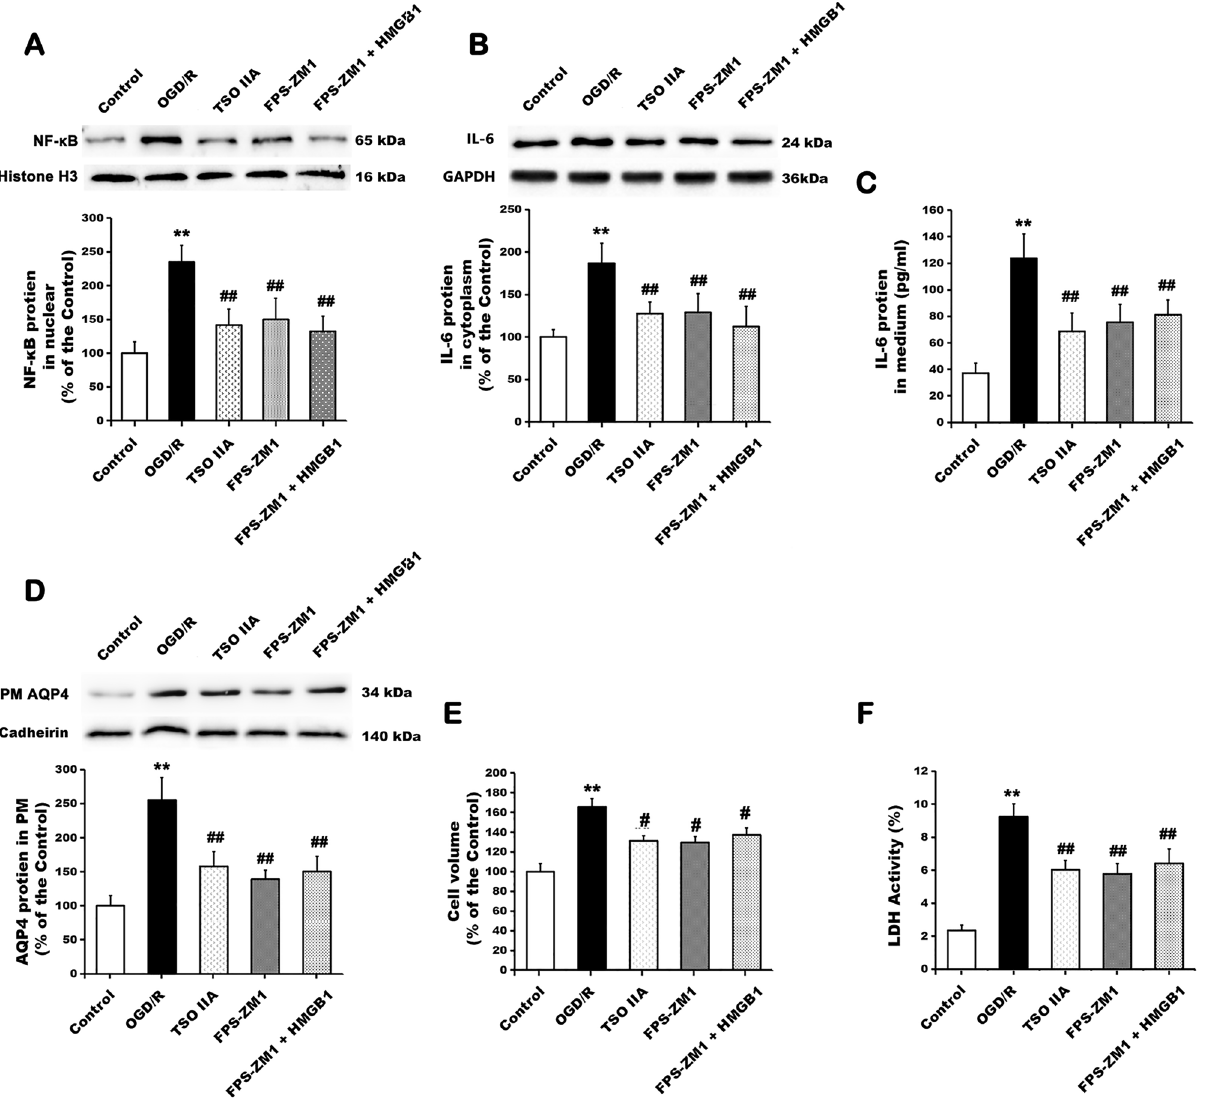
Figure 4. Effects of TSO IIA and FPS-ZM1 on the HMGB1-induced inflammatory axis, AQP4 clustering in the plasma membrane, and astrocytic swelling. ( A – C ) NF-κB protein accumulation in the nucleus and IL-6 protein expression in the cytoplasm and medium as examined by Western blot or ELISA after OGD/R in cells exposed to vehicle, TSO IIA, FPS-ZM1, or both FPS-ZM1 and HMGB1 ( n = 3 independent cultures). ( D – F ) AQP4 protein clustering in the plasma membrane, cell volume, and LDH activity after OGD/R was detected in cells in response to vehicle, TSO IIA, FPS-ZM1, or both FPS-ZM1 and HMGB1 ( n = 3 independent cultures). (The data of the aforementioned test are expressed as mean ± SEM. One-way ANOVA resulted in I < 0.01, ** P < 0.01 versus control; ## P < 0.01 versus OGD/R; CM: plasma